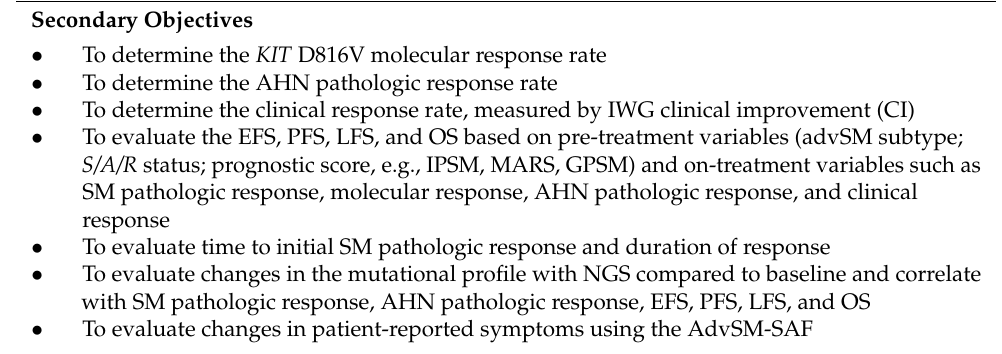
Table 5. A proposal for a protocol synopsis in advanced systemic mastocytosis with objectives reflecting tiered response